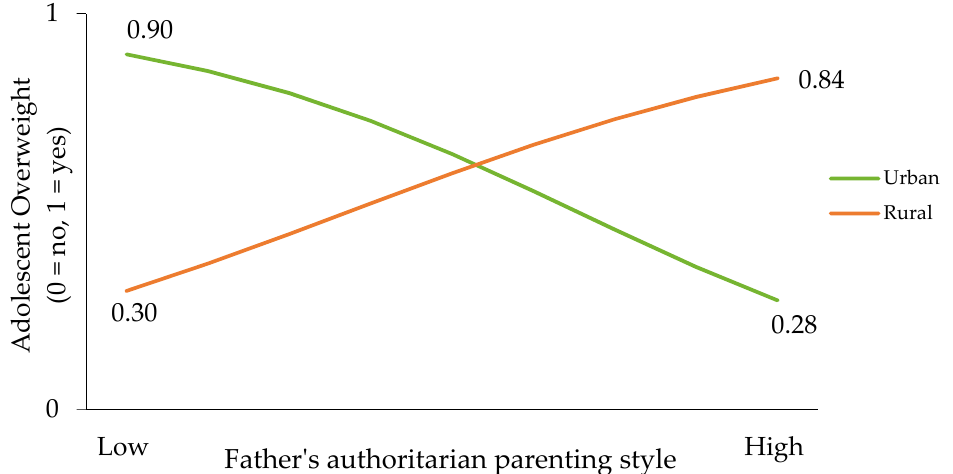
Figure 1. Moderating effect of area of residence on the relationship between authoritarian fathers and adolescent overweight.